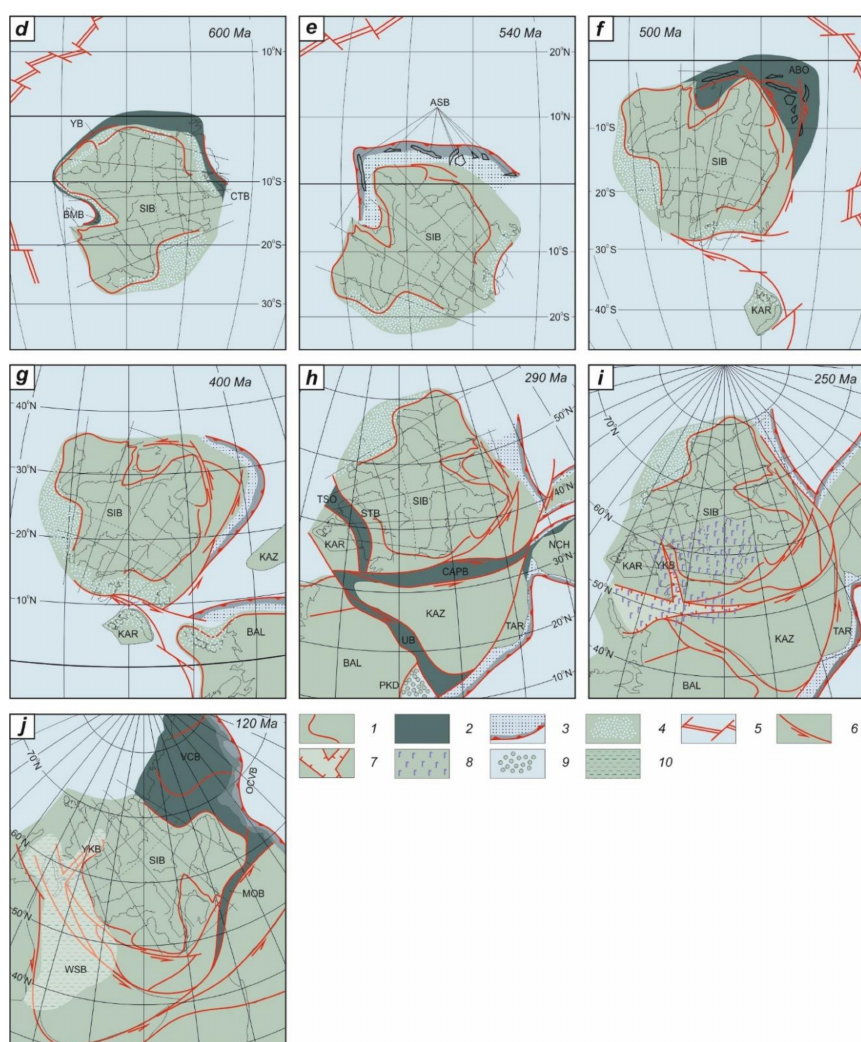
Figure 5. Paleotectonic reconstructions for the Siberian paleocontinent from the end of the Mesoproterozoic to the Early Cretaceous (adapted from Reference [25]). 1—continental masses and the most important contours; 2—accretionary structures and orogenic belts of corresponding ages; 3—subduction systems, including volcanic belts and back-arc basins; 4—marginal basins, shelves of passive continental margins; 5—inferred location of spreading zones; 6—general strike of transform/strike-slip zones with their strike-slip kinematics; 7—schematic area of thinning of the continental crust in the West Siberian graben-rift system; 8—schematic location of flood basalts of the Siberian trap late Permian—Early Triassic formation; 9—remnant basins with sub-oceanic crust; 10—schematic distribution of Mesozoic-Cenozoic deposits of the West Siberian sedimentation